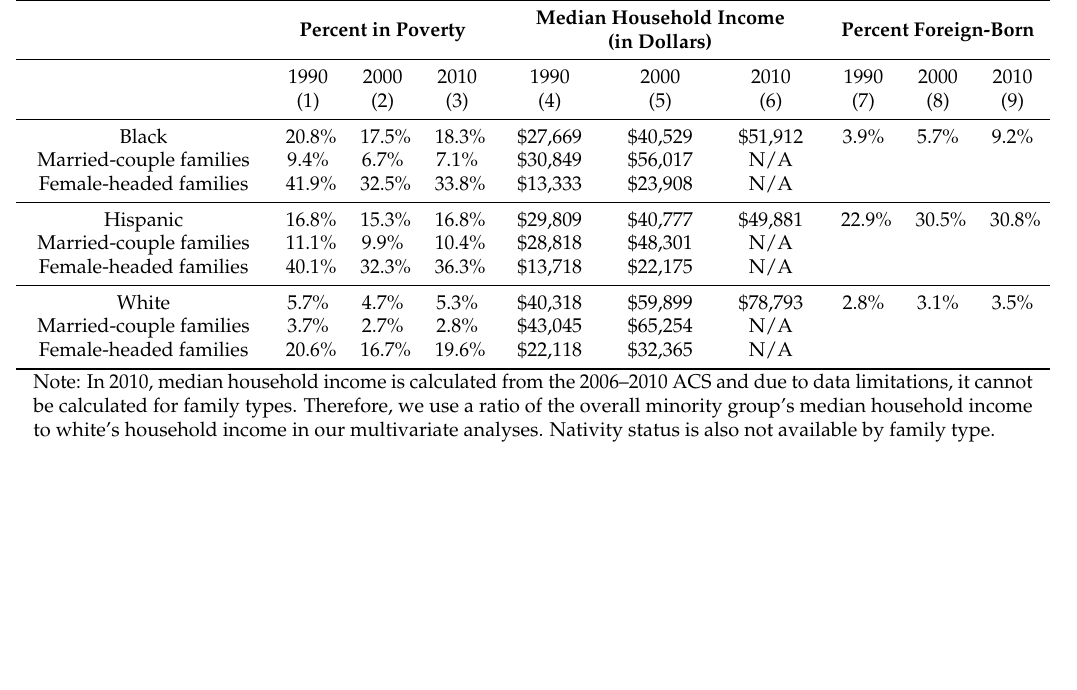
Table 4. Socioeconomic and demographic characteristics of families by structure, 1990–2010 Census and 2006–2010 ACS from the NCDB and